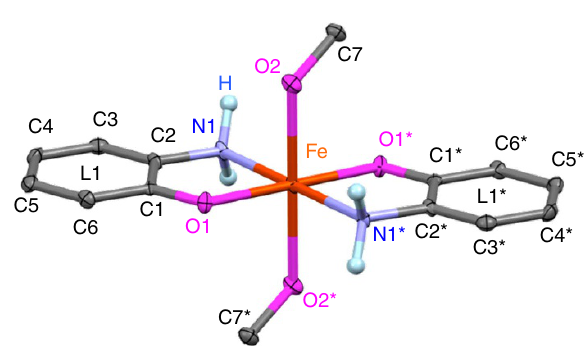
Figure 4 | Molecular structure of 1. Atomic displacement parameters set at 50% probability; colour code: C, dark grey; Fe, orange; N, light blue; O, magenta; ball-and-stick plots for N-bound hydrogen atoms (light blue), while all other hydrogen atoms are omitted for clarity. C1/C1*, C2/C2*, C3/C3*, C4/C4*, C5/C5*, C6/C6*, C7/C7*, N1/N1*, N2/N2*, O1/O1* and O2/O2* denote pairs of crystallographically equivalent atoms related by the symmetry operation 2– x , – y , 2– z